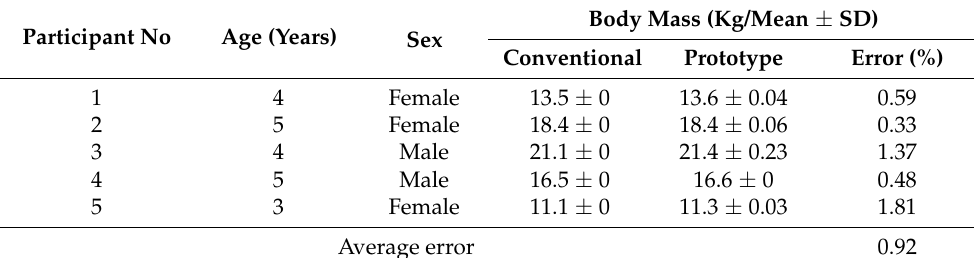
Table 5. Comparison between body mass measurement results using conventional tools (floor scale) and a prototype of an anthropometric